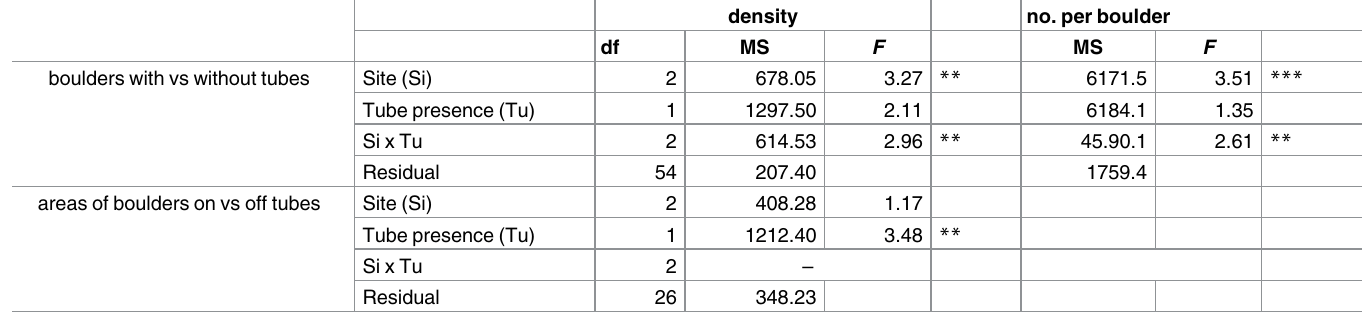
Table 2. Grazer assemblages differ significantly between areason vs off worm-tubes.